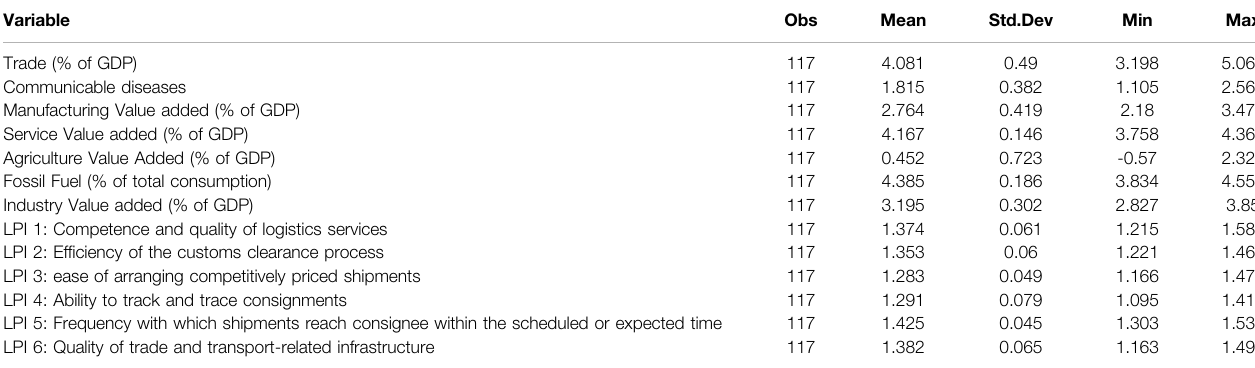
TABLE 2 | Descriptive statistics.